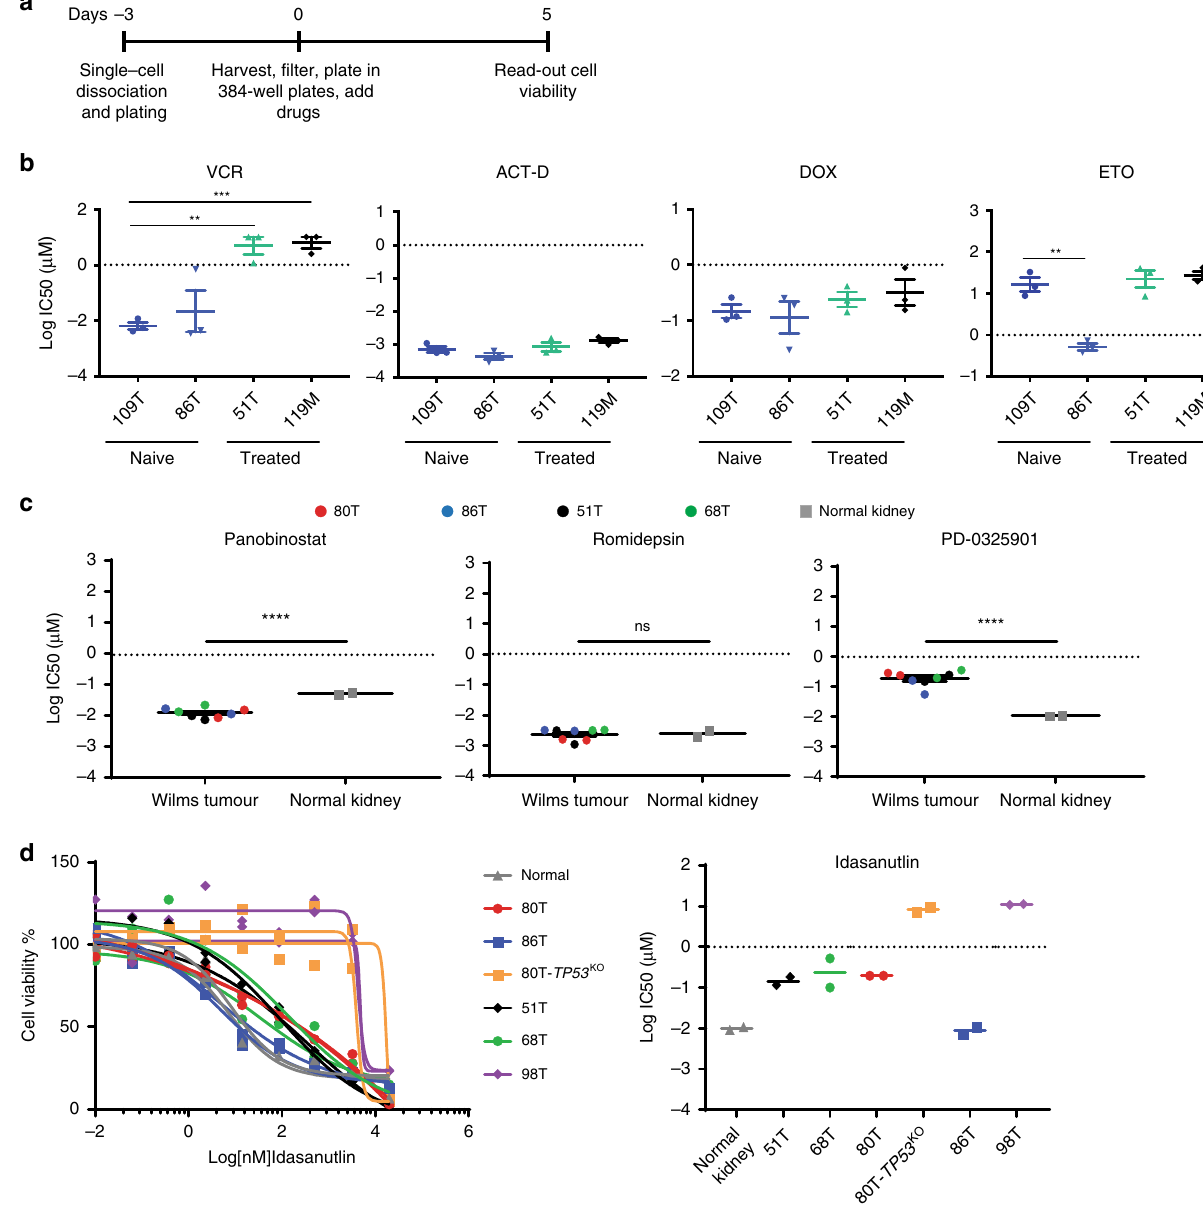
Fig. 6 Organoid drug screens reveal patient-speci fi c drug sensitivities. a Schematic overview of the organoid drug treatment experiment. b Graphs show the average IC 50 values of vincristine (VCR), actinomycin D (ACT-D), doxorubicin (DOX) and etoposide (ETO) in the indicated Wilms tumour organoid lines. In case the IC 50 value was not reached (see Supplementary Fig. 12a), the highest tested concentration was used for the calculations. Error bars represent SEM of three independent experiments (each individual experiment includes technical quadruplicates). P -values were calculated using a two- tailed Student ’ s t test, two-sided: **<0.01, ***<0.001. P -value VCR: 119 M vs 109T = 0.0005; 109T vs 51T = 0.0049. P -value ETO: 109T vs 86T = 0.0044. c Average IC 50 values of romidepsin, panobinostat and PD0325901 in the indicated Wilms tumour and normal kidney organoid cultures. Each dot/square (two per organoid culture) represents the average of technical quadruplicates of an individual organoid culture. P -values were calculated using a two-tailed Student ’ s t test, two-sided: ****<0.0001. P -value Romidepsin: Wilms tumour vs normal kidney = 0.8339. d Dose – response curves (left) and average IC 50 (right) of Idasanutlin on the indicated Wilms tumour and normal kidney organoid cultures. As control for P53 function, 80T- TP53 KO organoids were included, thereby demonstrating that anaplastic Wilms tumour-derived organoids (98T) are less sensitive to Idasanutlin treatment. Curves with the same colour represent independent experiments. Each individual point represents the average of quadruplicate measurements. Source data are provided as a Source Data fi etoposide (ETO) 5 . We used two chemo-naive (109T, 86T) Wilms drug allowed us to generate reproducible dose – response curves tumour organoid lines and two that were derived of chemo- (Supplementary Fig. 12a) and calculate half-maximal inhibitory treated Wilms tumours (51T, 119M) and subjected those to a concentrations (IC 50 ) (Fig. 6b). While organoids derived from previously established drug-screening platform and cell viability both pre-treated Wilms tumours were signi fi cantly less sensitive read-out 33 (Fig. 6a). Testing six different concentrations per to VCR than the untreated Wilms tumour organoids, similar